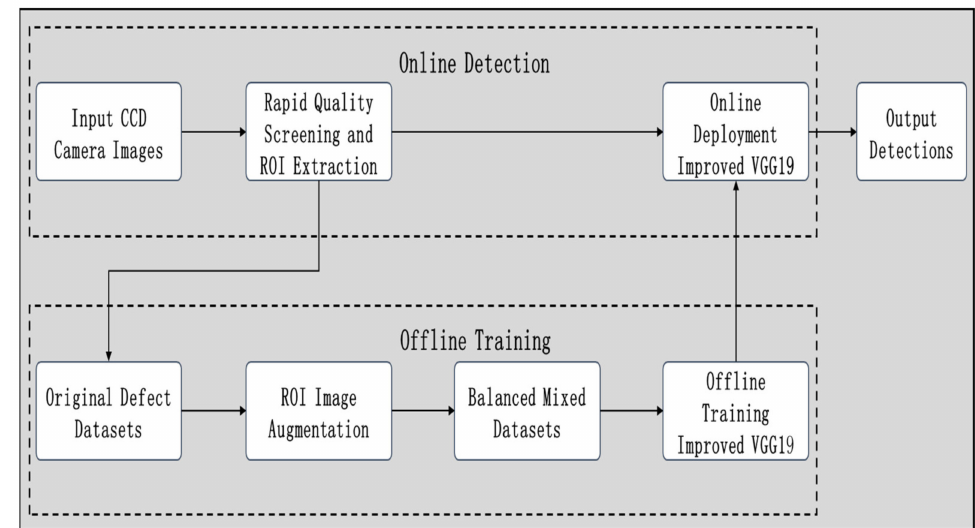
Figure 1. Overview of the strip steel defect detection